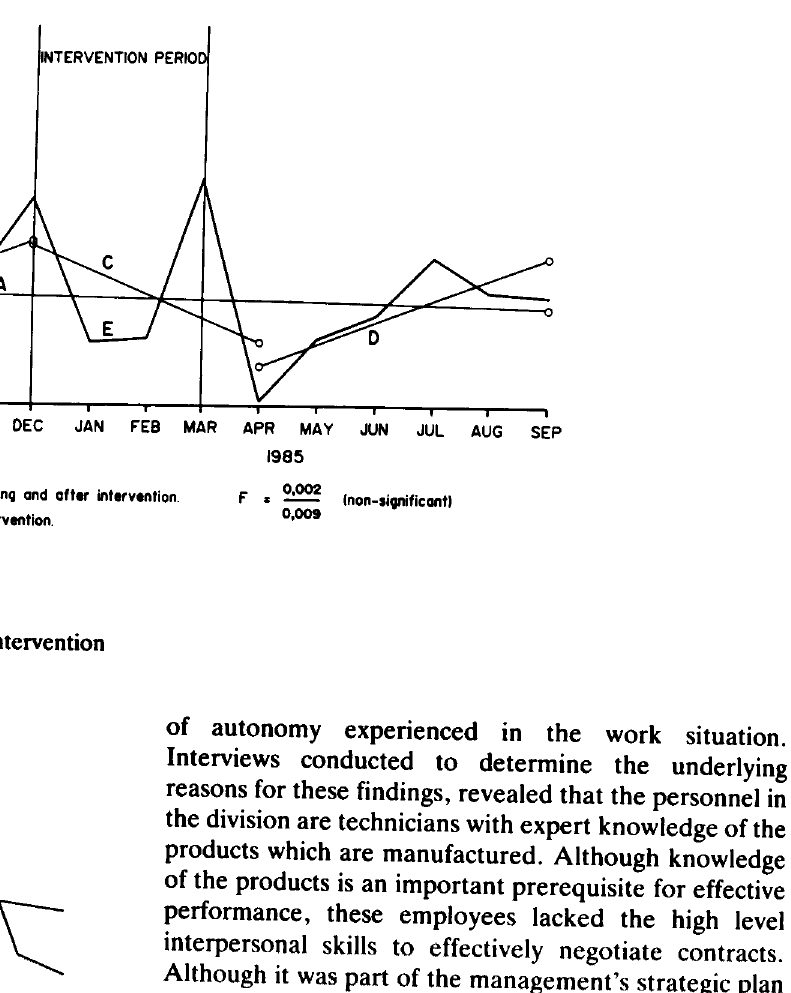
Figwe 3 Absenteeism before, during and after intervention